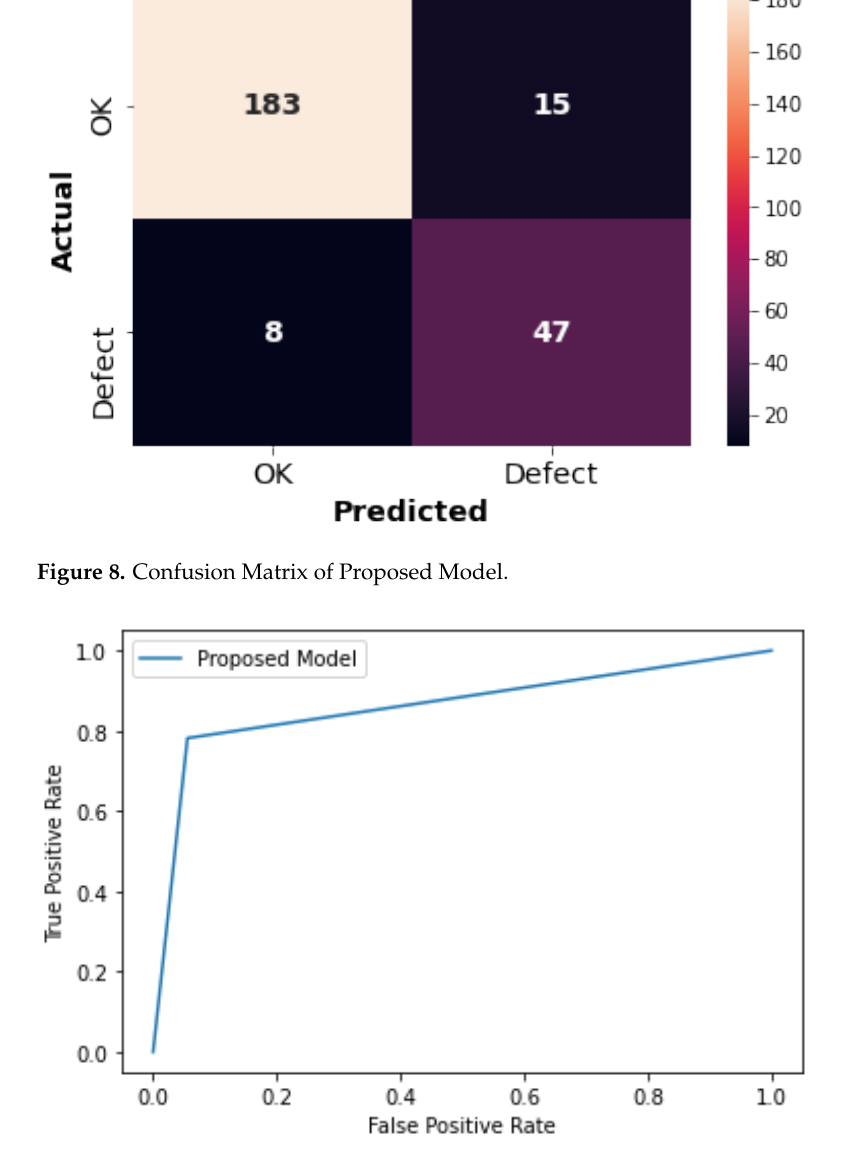
Figure 9. ROC Curve of Proposed Model.